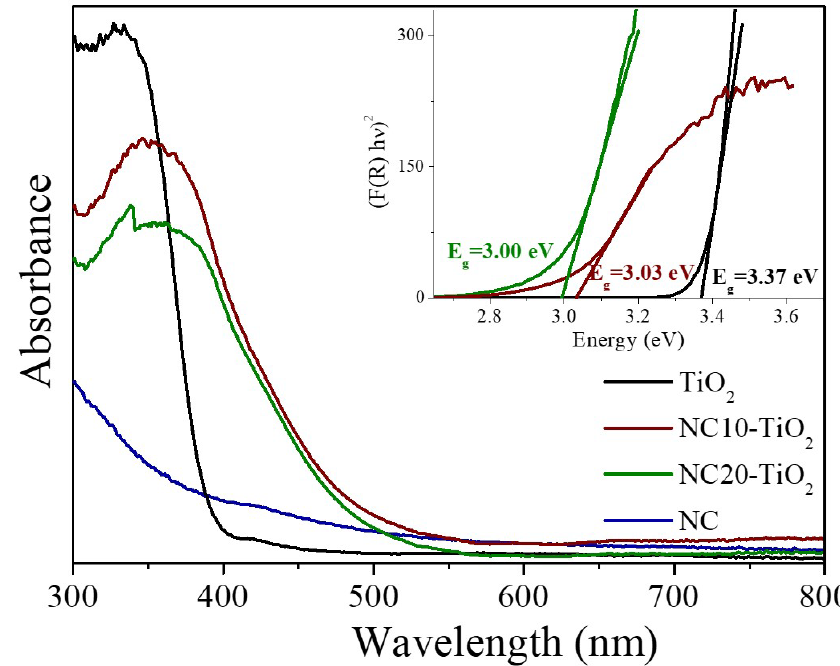
Figure 4. UV–vis spectra for ( – ) TiO 2 , ( – ) NC10–TiO 2 , ( – ) NC20–TiO 2 nanocomposites, and ( – ) NC.